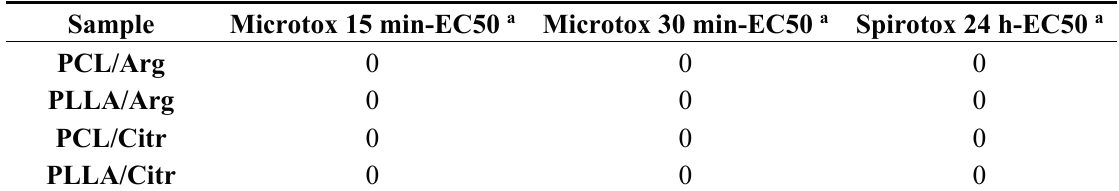
Table 1. The cytotoxicity results of the synthesized polymeric matrices.